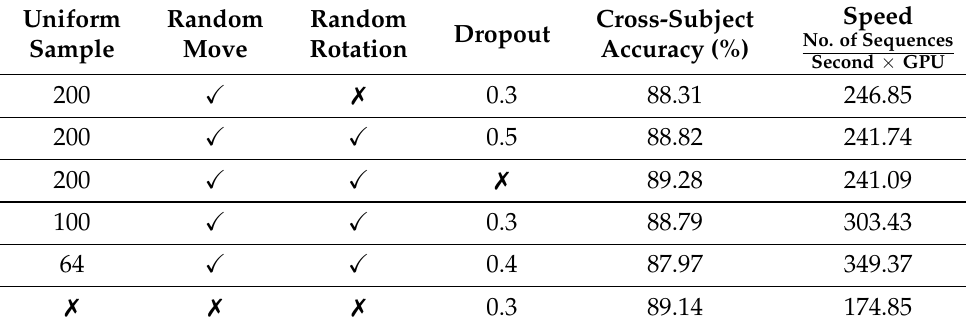
Table 2. Performances obtained depending on the augmentation transforms and the probability of the Dropout layer, where (cid:88) signifies the application of the transformation and (cid:55) indicates that we not included operation in the augmentation stage.